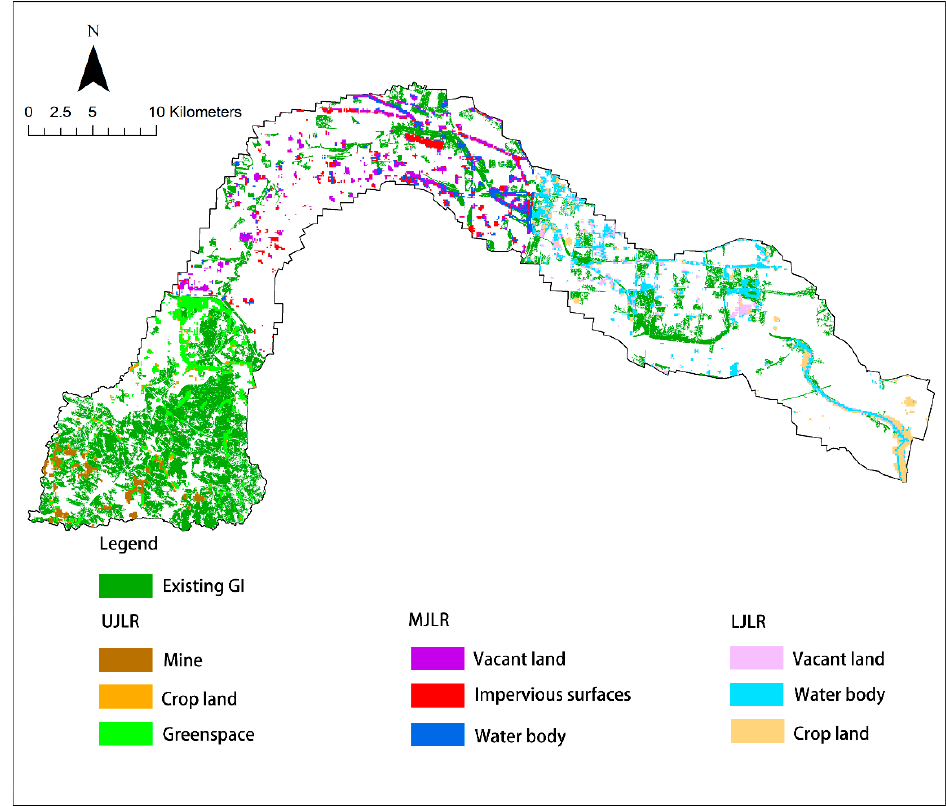
Figure 8. Priority types segregated by using both global bivariate Moran’s I values and local bivariate Moran’s I.